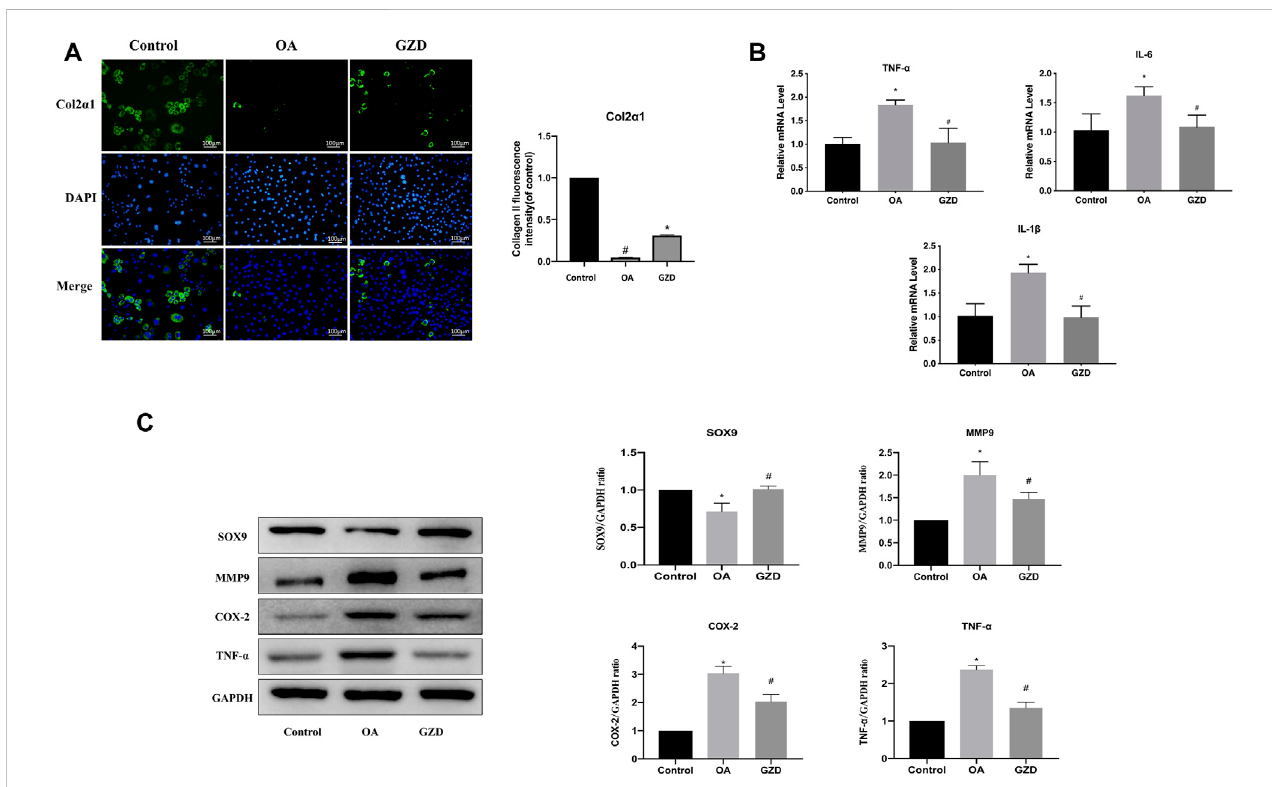
FIGURE 6 AnalysisoftheTNFsignalingpathwaychangesinchondrocytes. (A) Representative fl uorescentimagesofcellsstainedforCol2 α 1(green),withDAPIbeing used for nuclear counterstaining (blue). Col2 α 1 fl uorescent signal in these cells are quanti fi ed (right). (B) Expressions of hub genes (TNF- α , IL-6, and IL-1 β ) are assessed via qPCR, with GAPDH for normalization. (C) RepresentativeWB ofTNF signaling pathway and gene levels normalized to GAPDH expression in vitro . Data are mean ± SD from three independent experiments. * p < 0.05 vs. Control group; # p < 0.05 vs. OA